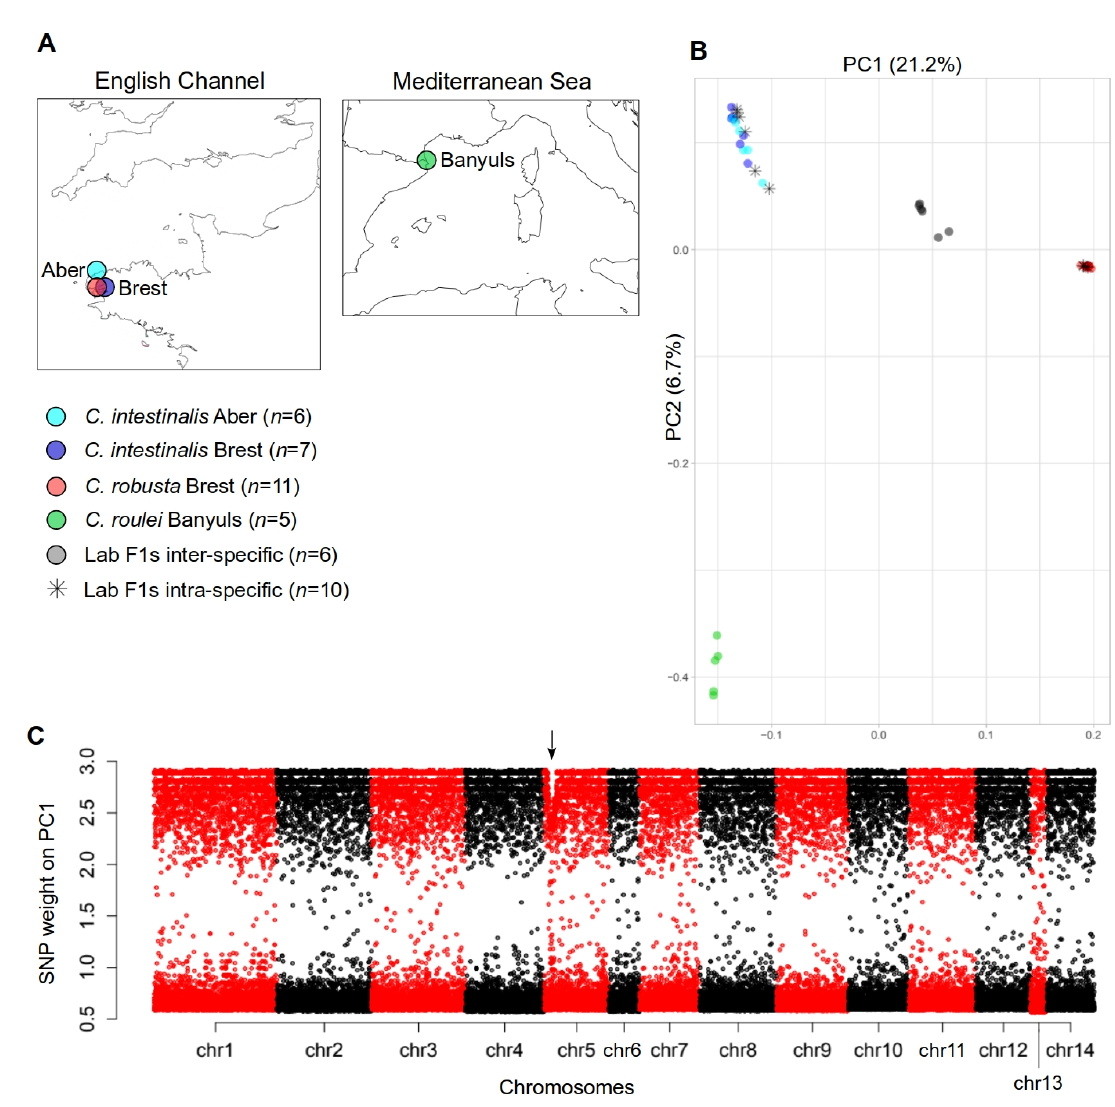
Figure 1: G enetic population structure. A. Geographical location of the samples in the English Channel and Iroise Sea ( C. robusta and C. intestinalis ) and the Mediterranean Sea ( C. roulei ). Numbers in brackets refer to the sample size of each population. “Lab F1s” indicates the intraspecific and interspecific offspring produced in the laboratory. Further information on samples is provided in Table S1 . The color code ( C. robusta in red, C. intestinalis in blue and C. roulei in green) is used throughout the manuscript. B. Principal Component Analysis of 45 individuals genotyped at 194,742 unlinked SNPs (pruning threshold: r2 > 0.1). Numbers in brackets refer to the proportion of variance explained by each axis. Three poorly sequenced parents were removed from the analysis (see Table S1 ). C. SNP weights to the first axis of the PCA (after removing the SNPs contributing less than the 75th quantile of the weight distribution). The introgression hotspot on chromosome 5 is highlighted with an arrow. Dataset #1 “phased SNPs with offspring” was